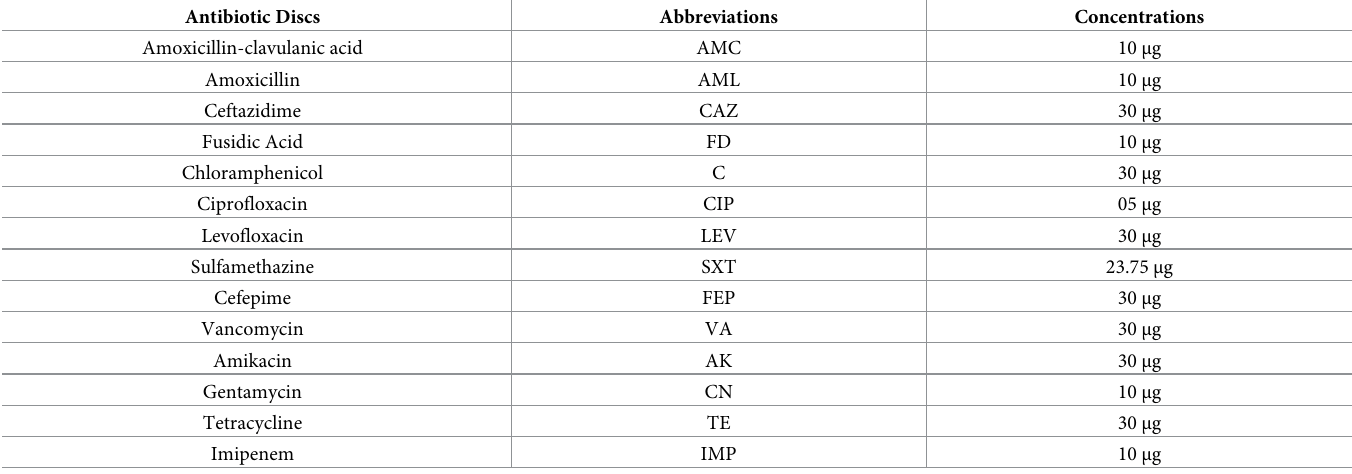
Table 2. List of antibiotic discs used for the detection of MDR K . pneumoniae